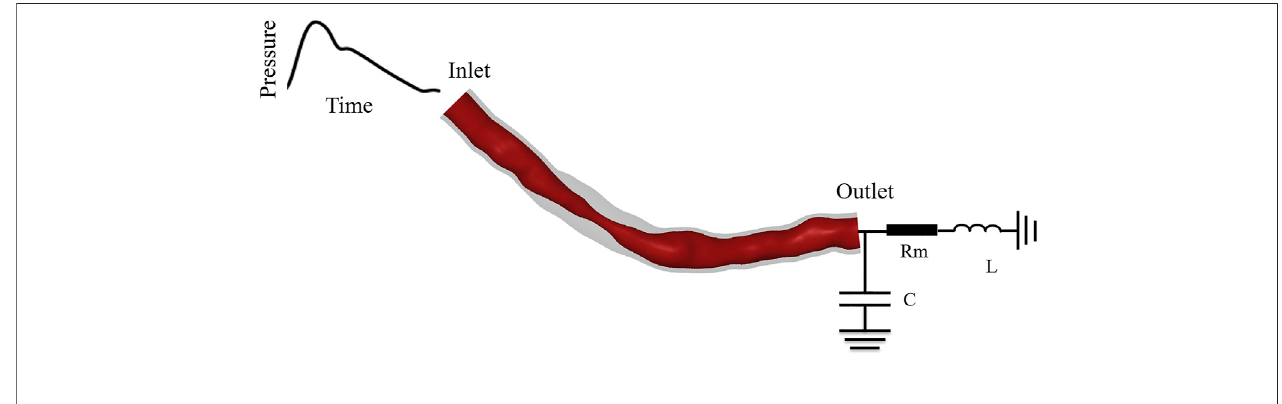
FIGURE 1 | Dual-coupled coronary model with 70% stenosis and 10 mm stenosis